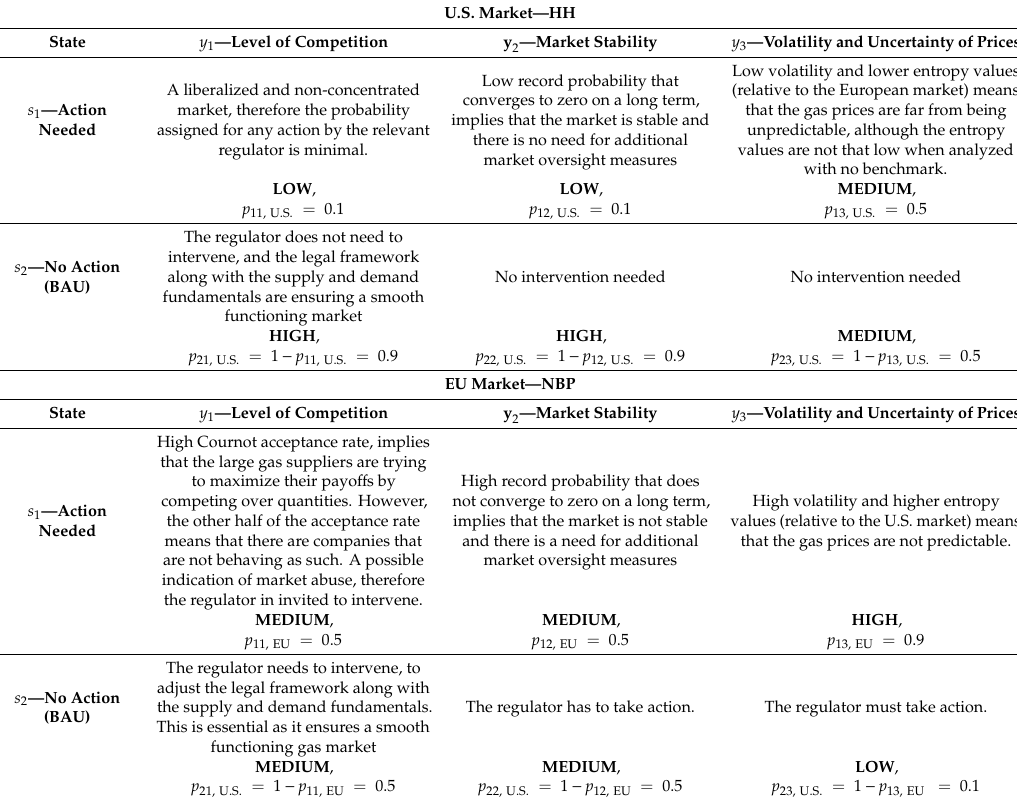
Table 9. Information structure conditional probabilities for both